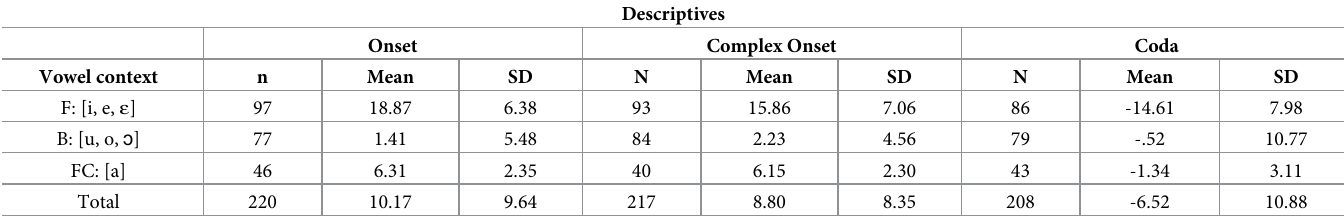
transition (Hz/ms) in onset, complex onset and coda 2